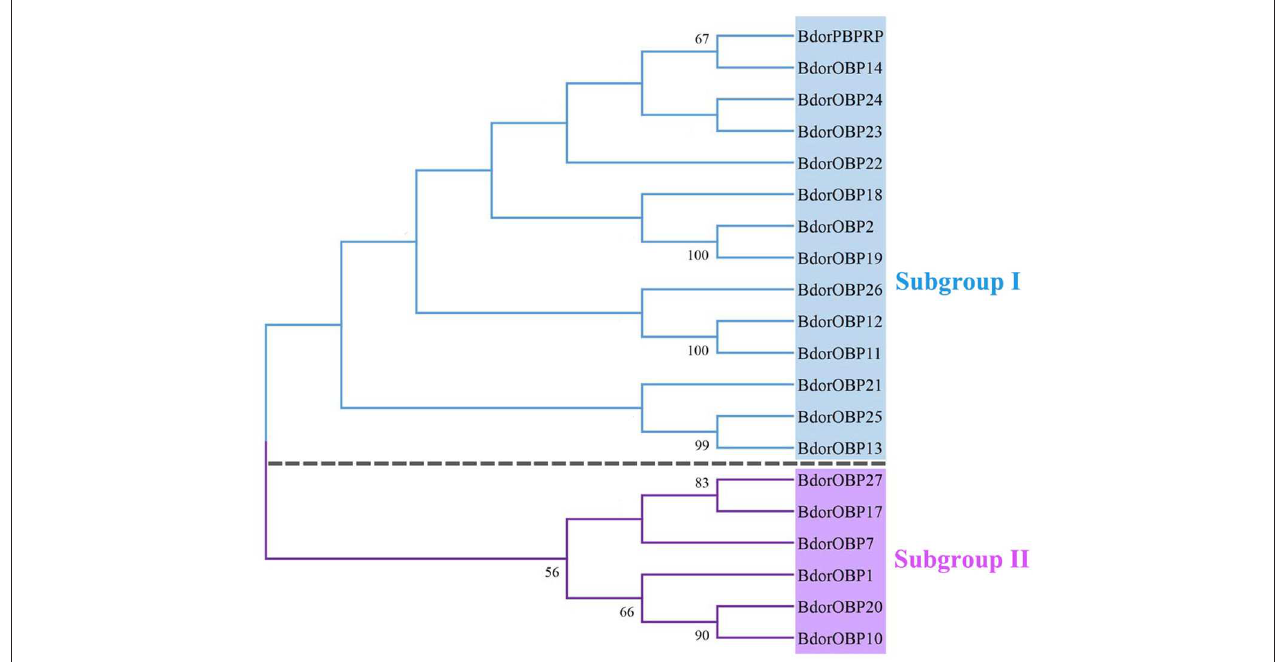
FIGURE 2 | Phylogenetic relationships of the OBP proteins. Unrooted phylogenetic tree of OBP protein sequences from B. dorsalis constructed with the MEGA 5.0 tool. The identified OBPs are classified into subgroup I and subgroup II based on the sequences. The bootstrap values above 50 are